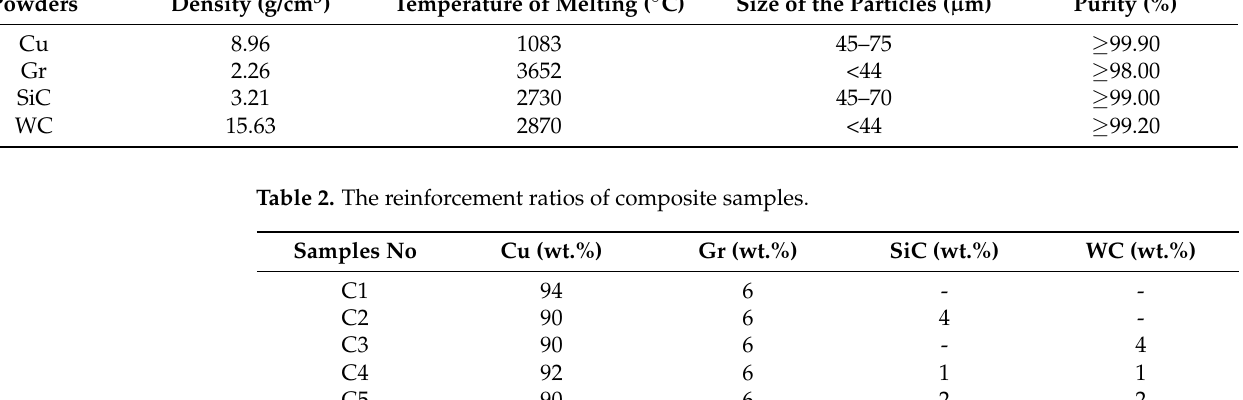
Table 1. Some powder particle characteristics.